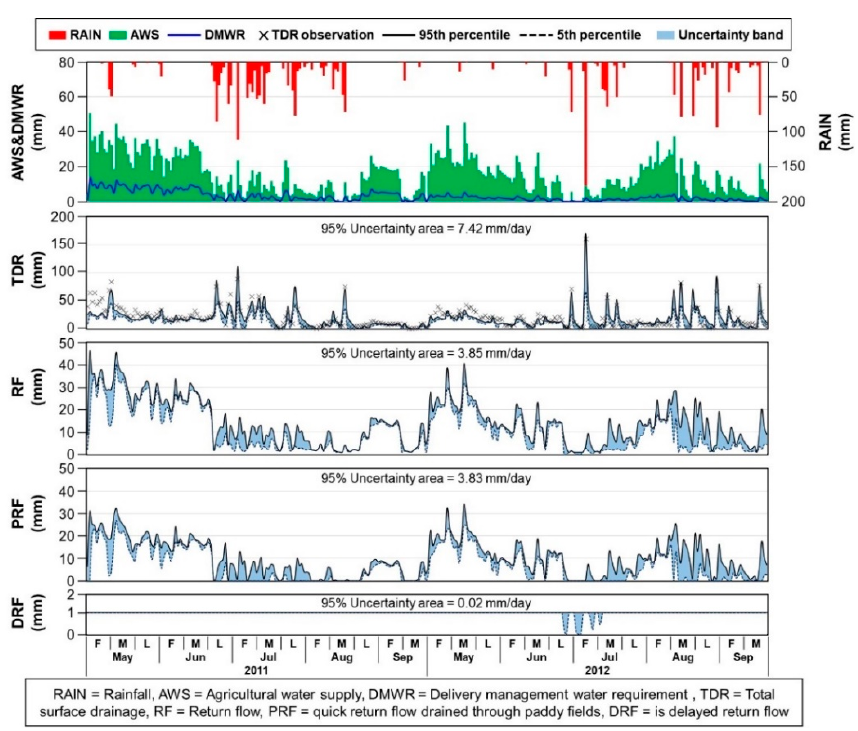
Figure 6. Temporal variations of inputs ( RAIN and AWS ), outputs ( DMWR , TDR , RF , PRF , and DRF ), and uncertainty (the 95% confidence interval) of output modeling using the Narrow-CON approach. Simulated TDR is compared with the observations.